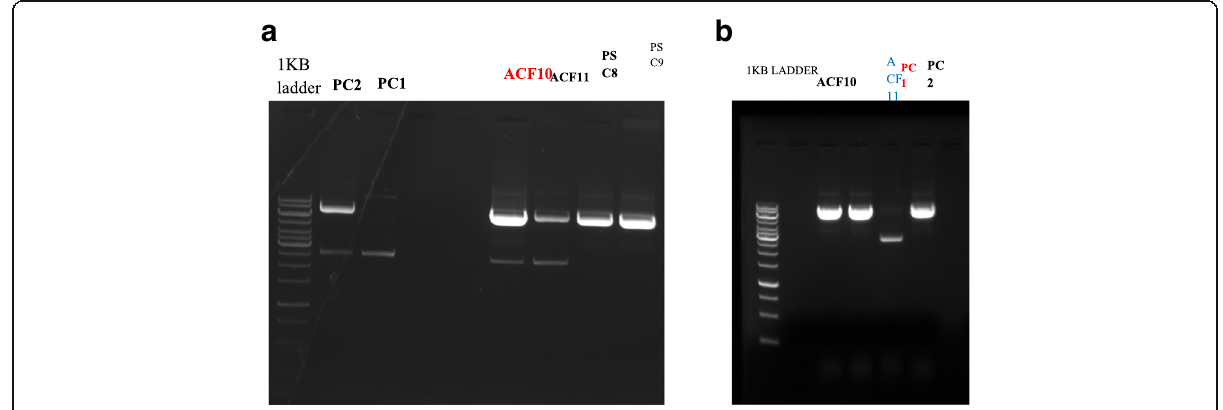
Fig. 7 a and b 1% agarose gel of positive pAc-sgRNA-Cas9-puro-vector constructs for Pc, Acf and Psc